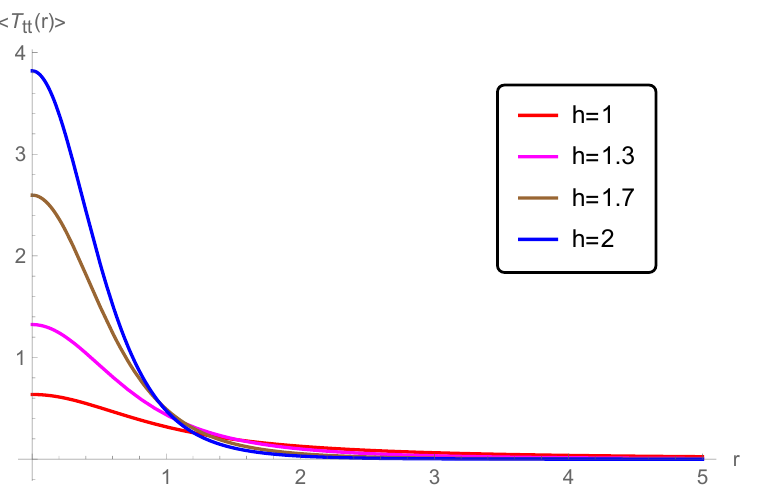
in the one-particle state for different conformal tt